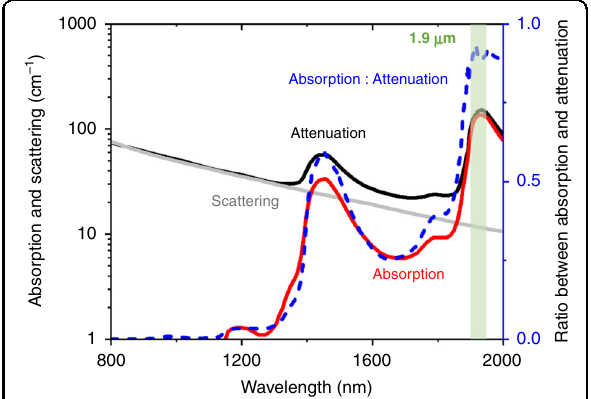
Fig. 1 The absorption and scattering of water in the spectral window of 800 – 2000 nm 10,11 . The attenuation is a sum of absorption and scattering. The ratio of absorption to attenuation is peaked around 1900